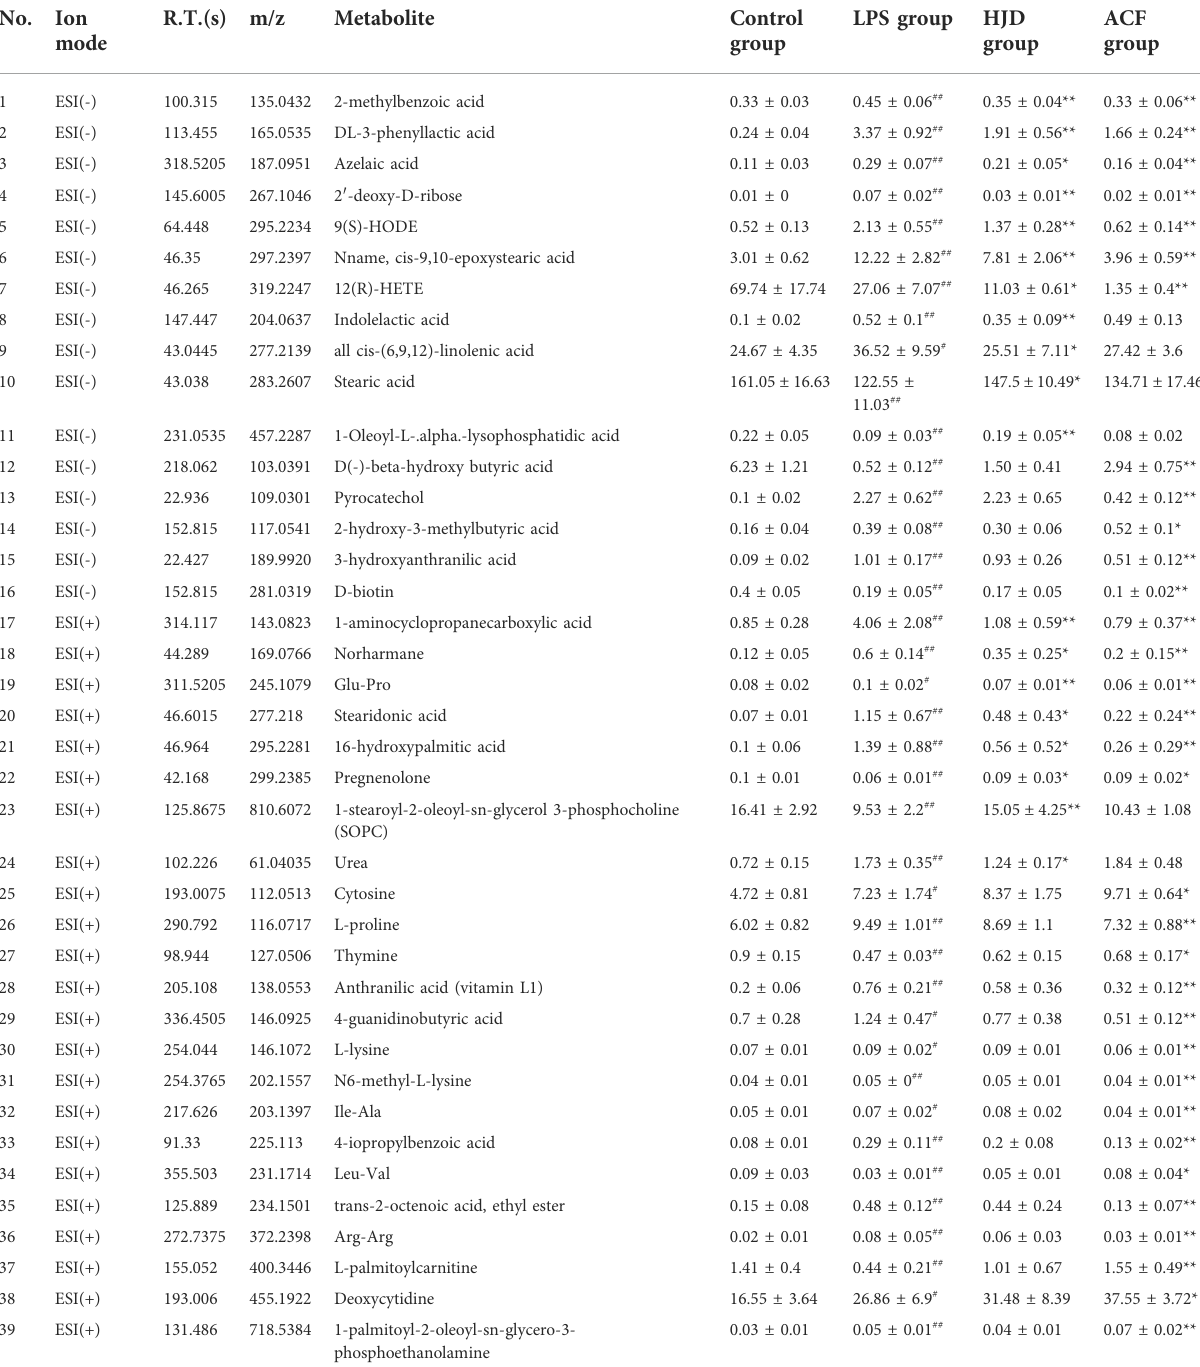
TABLE 3 Mass databases of 39 potential differential